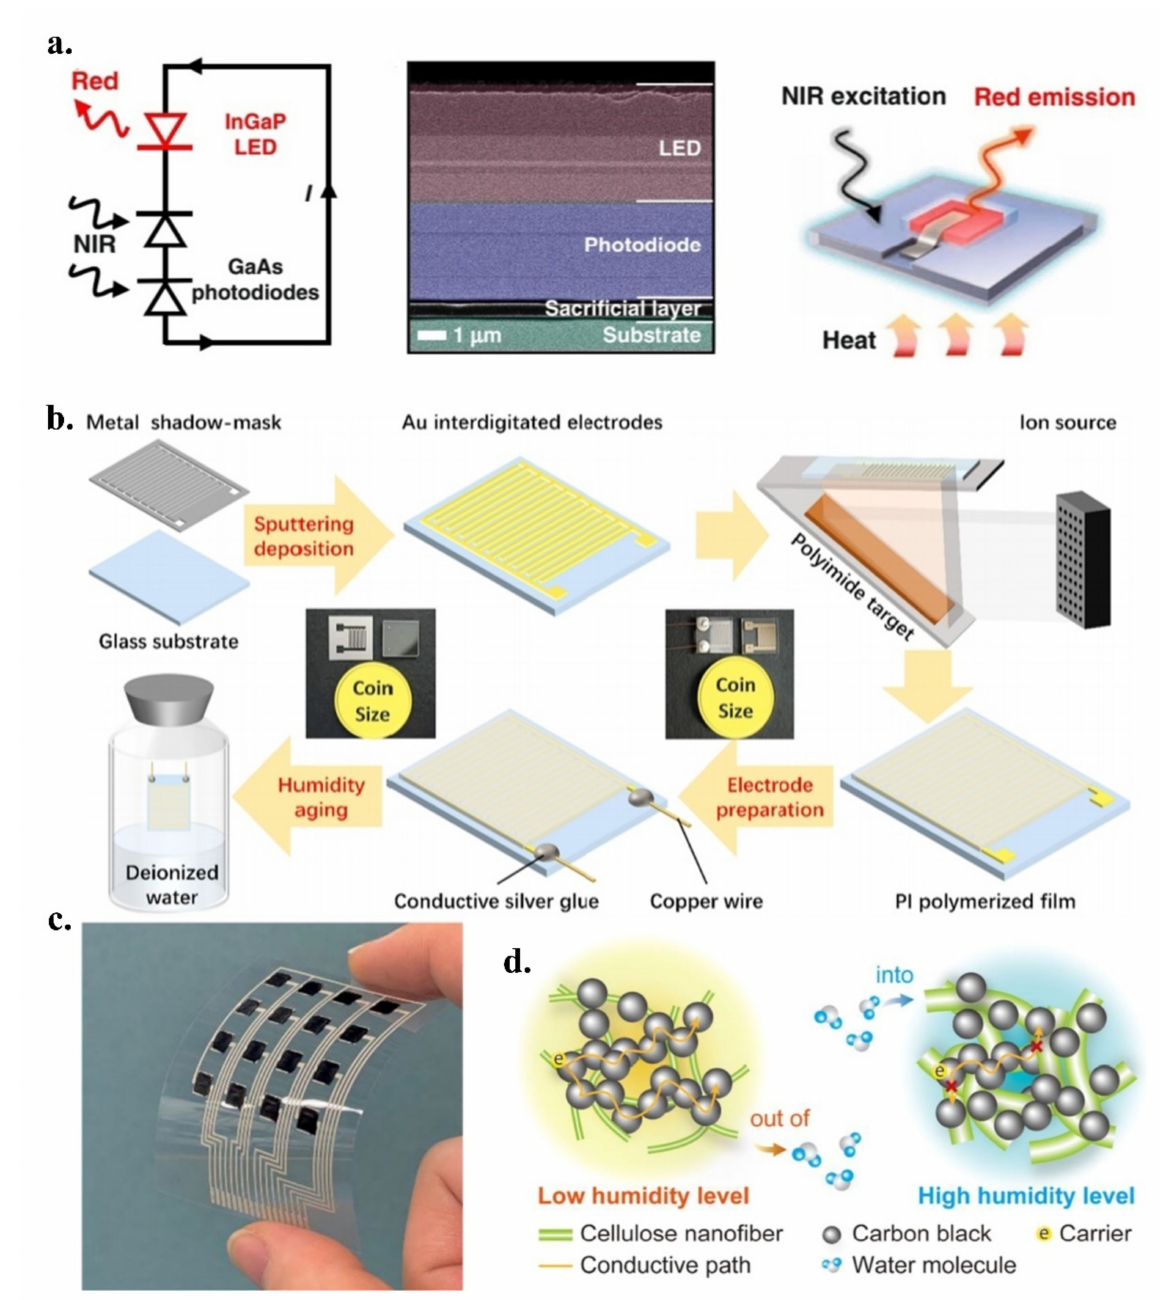
Figure 6. ( a ) Fibre-optic temperature sensor based on photoelectric up conversion; reproduced with permission from Springer Nature (2022) [116]; ( b ) Polyimide-sputtered and polymerised gas humidity sensor; reproduced with permission from the American Chemical Society (2022) [119]; ( c ) Ink-based printing flexible humidity sensor; reproduced with permission from the American Chemical Society (2022) [121]; ( d ) Schematic of the humidity detection mechanism for the cellulose nanofibres/carbon black composite; reproduced with permission from the American Chemical Society (2022)